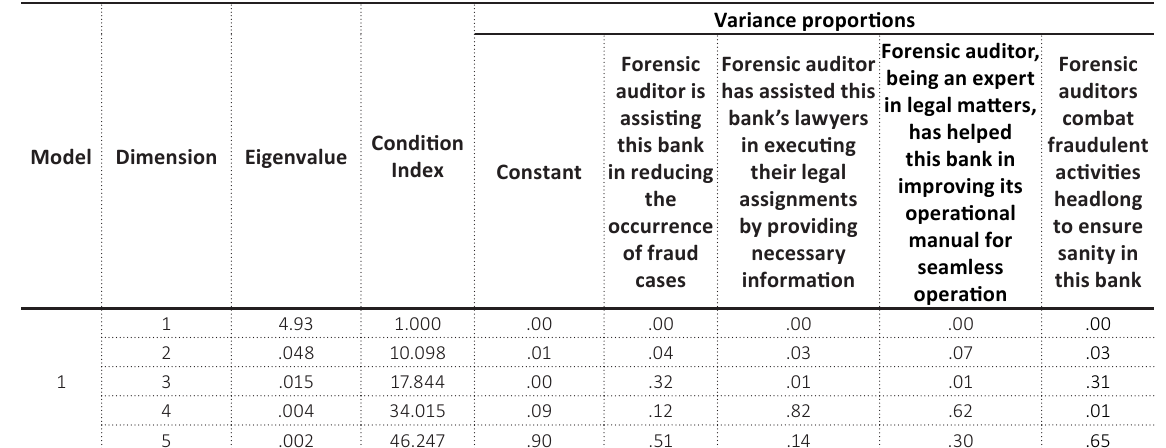
Table 10. Collinearity diagnostics a